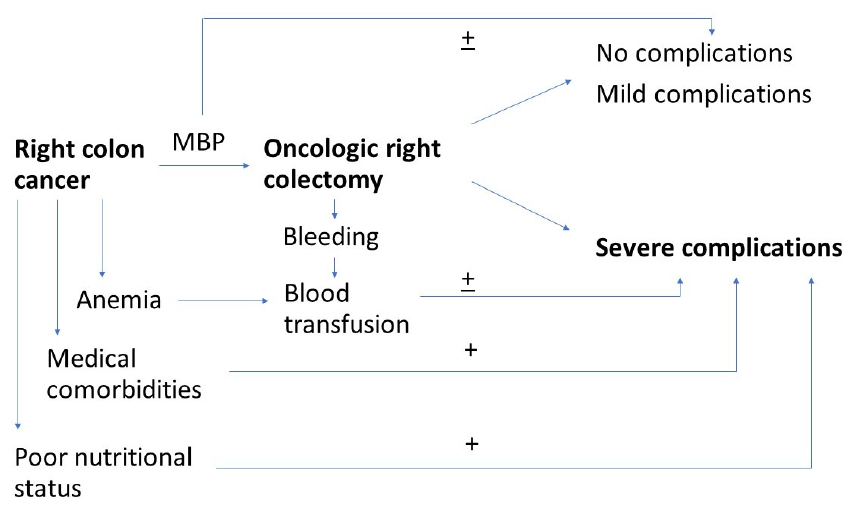
Figure 1. Factors associated with severe postoperative complications after oncologic right colectomy.